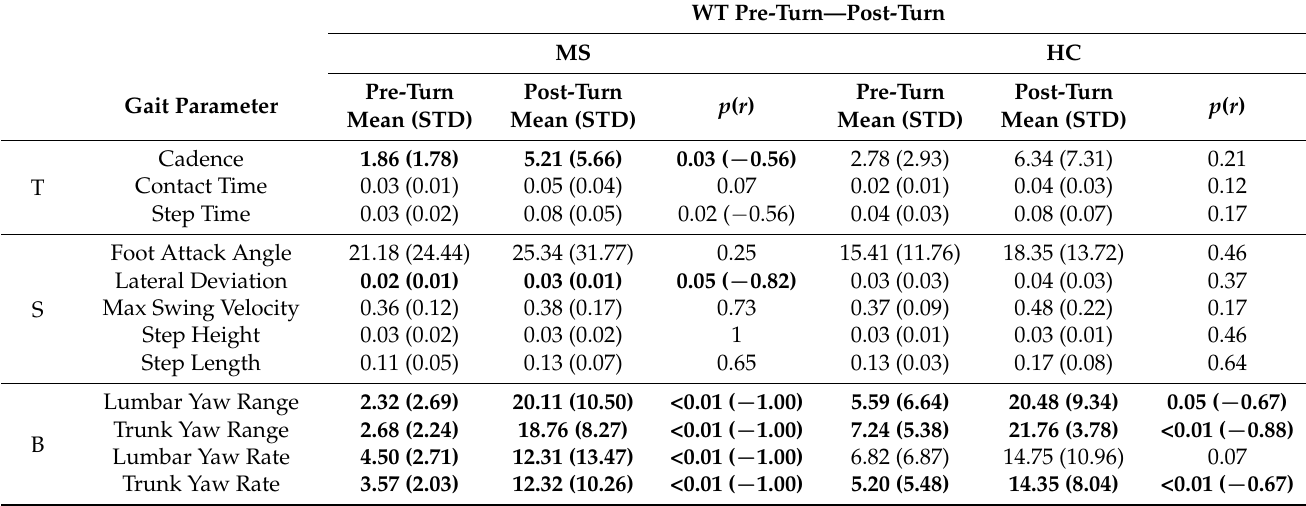
Table 2. Comparisons of gait variability during phases of the walk and turn task (pre-turn—post-turn) for PwMS and controls (HC). p -values ( p ) are reported for each comparison with effect sizes ( r ) indicated for significant differences. WT Pre-Turn—Post-Turn MS HC